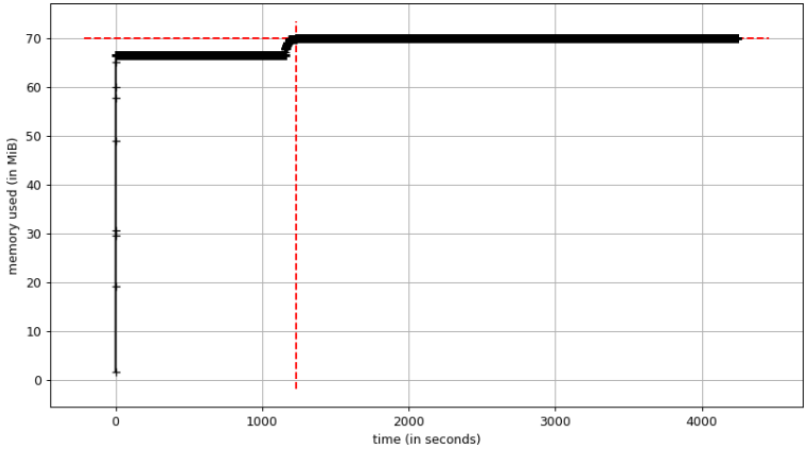
Figure 8. Memory profiler